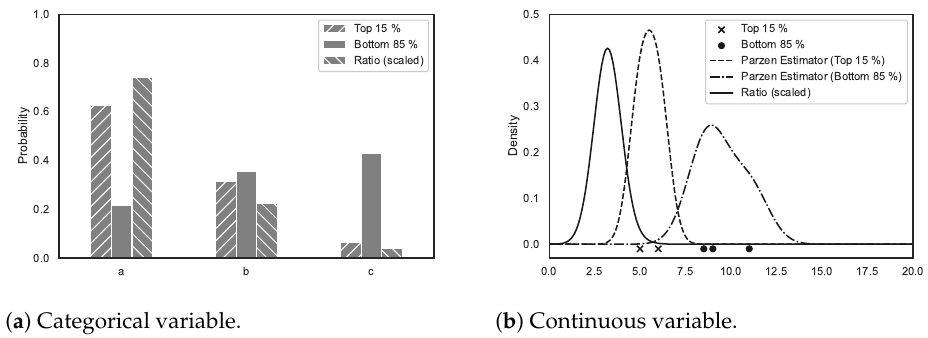
Figure 4. The Tree-structured Parzen Estimation (TPE) uses the ratio of better- and worse-performing parameters to guide the search. In the example on the left, the categorical variable takes one of the three values “a”, “b”, and “c”. For the continuous variable, in the example on the right the values range from 0 to 20.